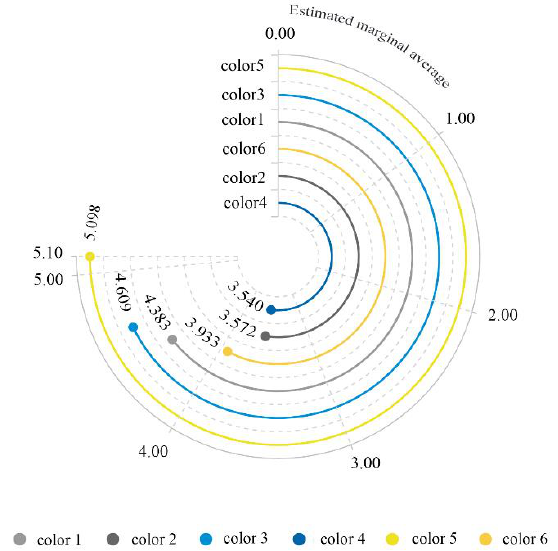
Figure 6. Estimated marginal average of emotional